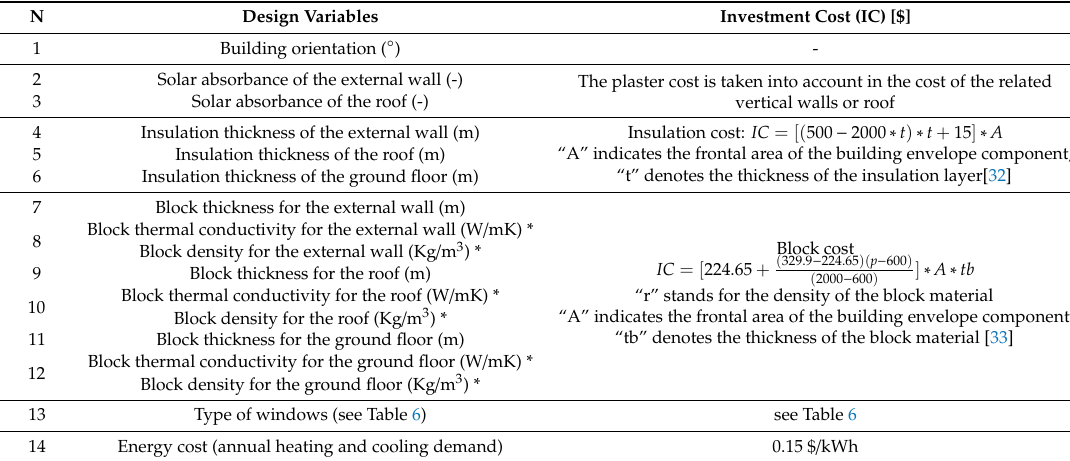
Table 7. Calculation method of initial investment